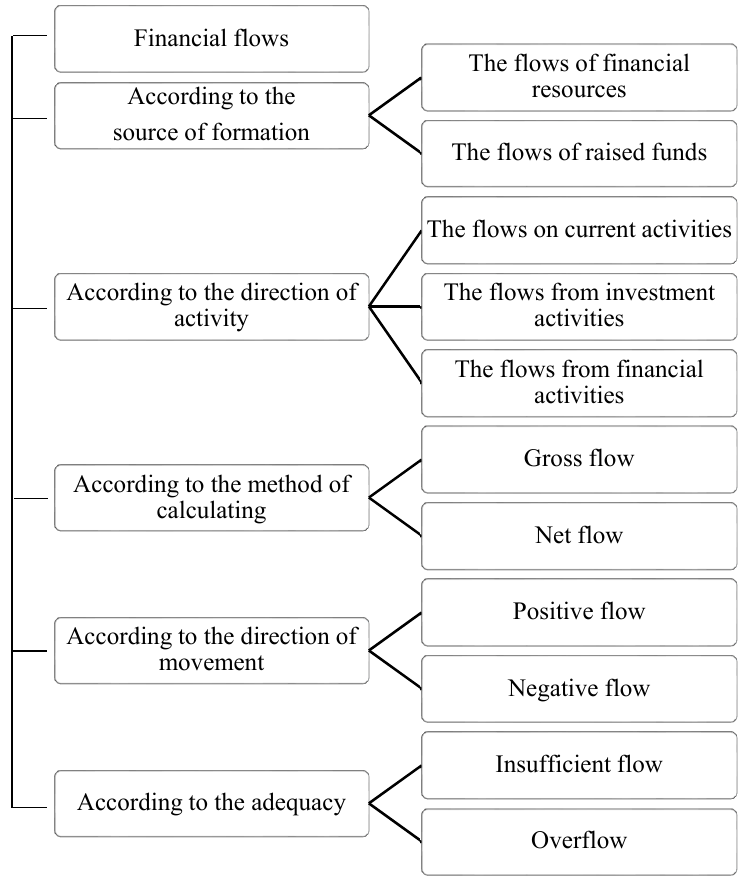
Figure 2. The classification of financial flows. Developed by authors.